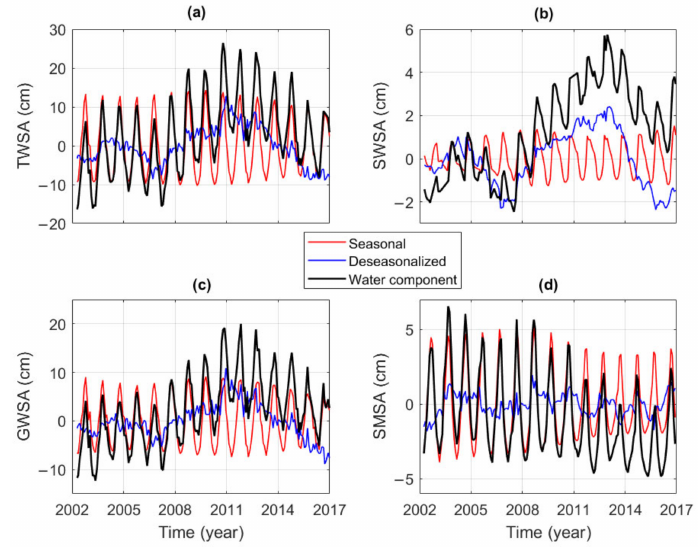
Figure 10. Temporal component time series of ( a ) TWSA VFL ; and water component from ( b ) Altimetry − imageries estimated SWSA, ( c ) GWSA VFL and ( d ) GLDASderived SMSA. The al- timetryimageriesderived SWSA were obtained by combining both Lake Volta and Bui reservoir estimated surface water storage changes. Monthly time series of water storages were de-seasonalized by removing the linear trend and seasonal signals. The seasonal component in each water storage was derived by applying the seasonal and trend decomposition using the loess (STL) algorithm while the linear trend was estimated using the least square fitting approach. All the time series were averaged over Volta Fractured Land from 2002 to